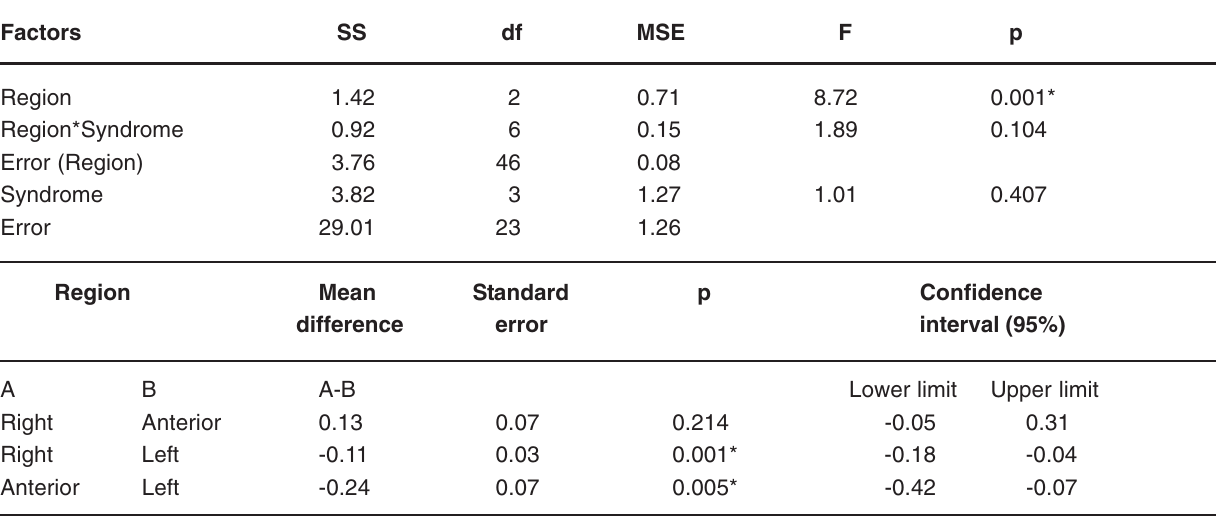
TABLE 5- Comparison of plaque index according to region and syndrome